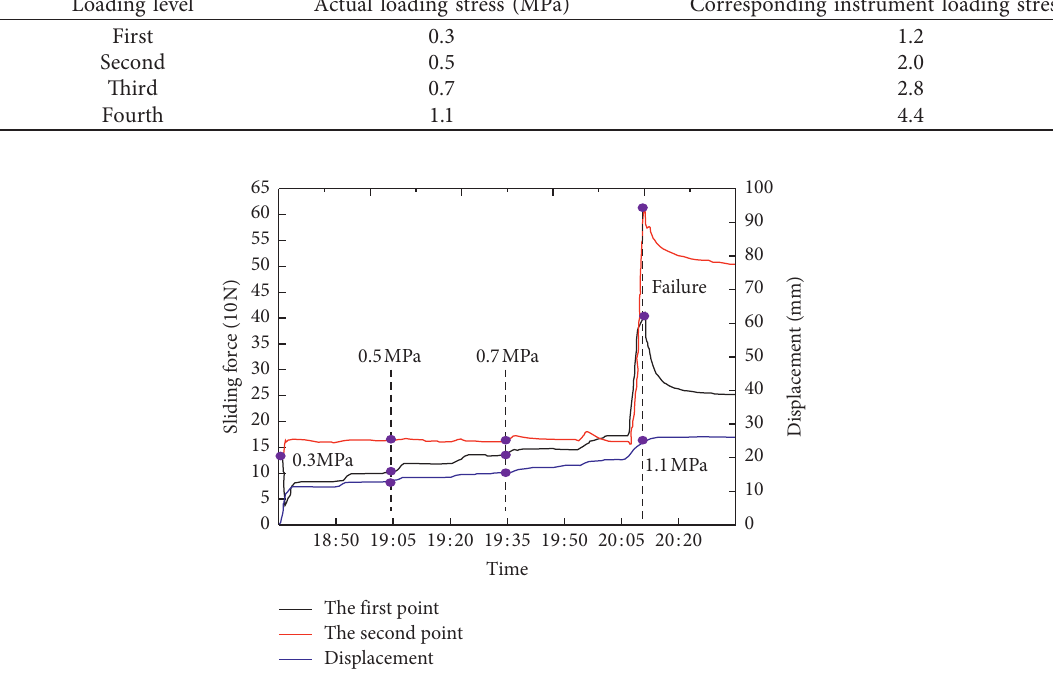
Figure 11: Displacement and sliding force time curve.